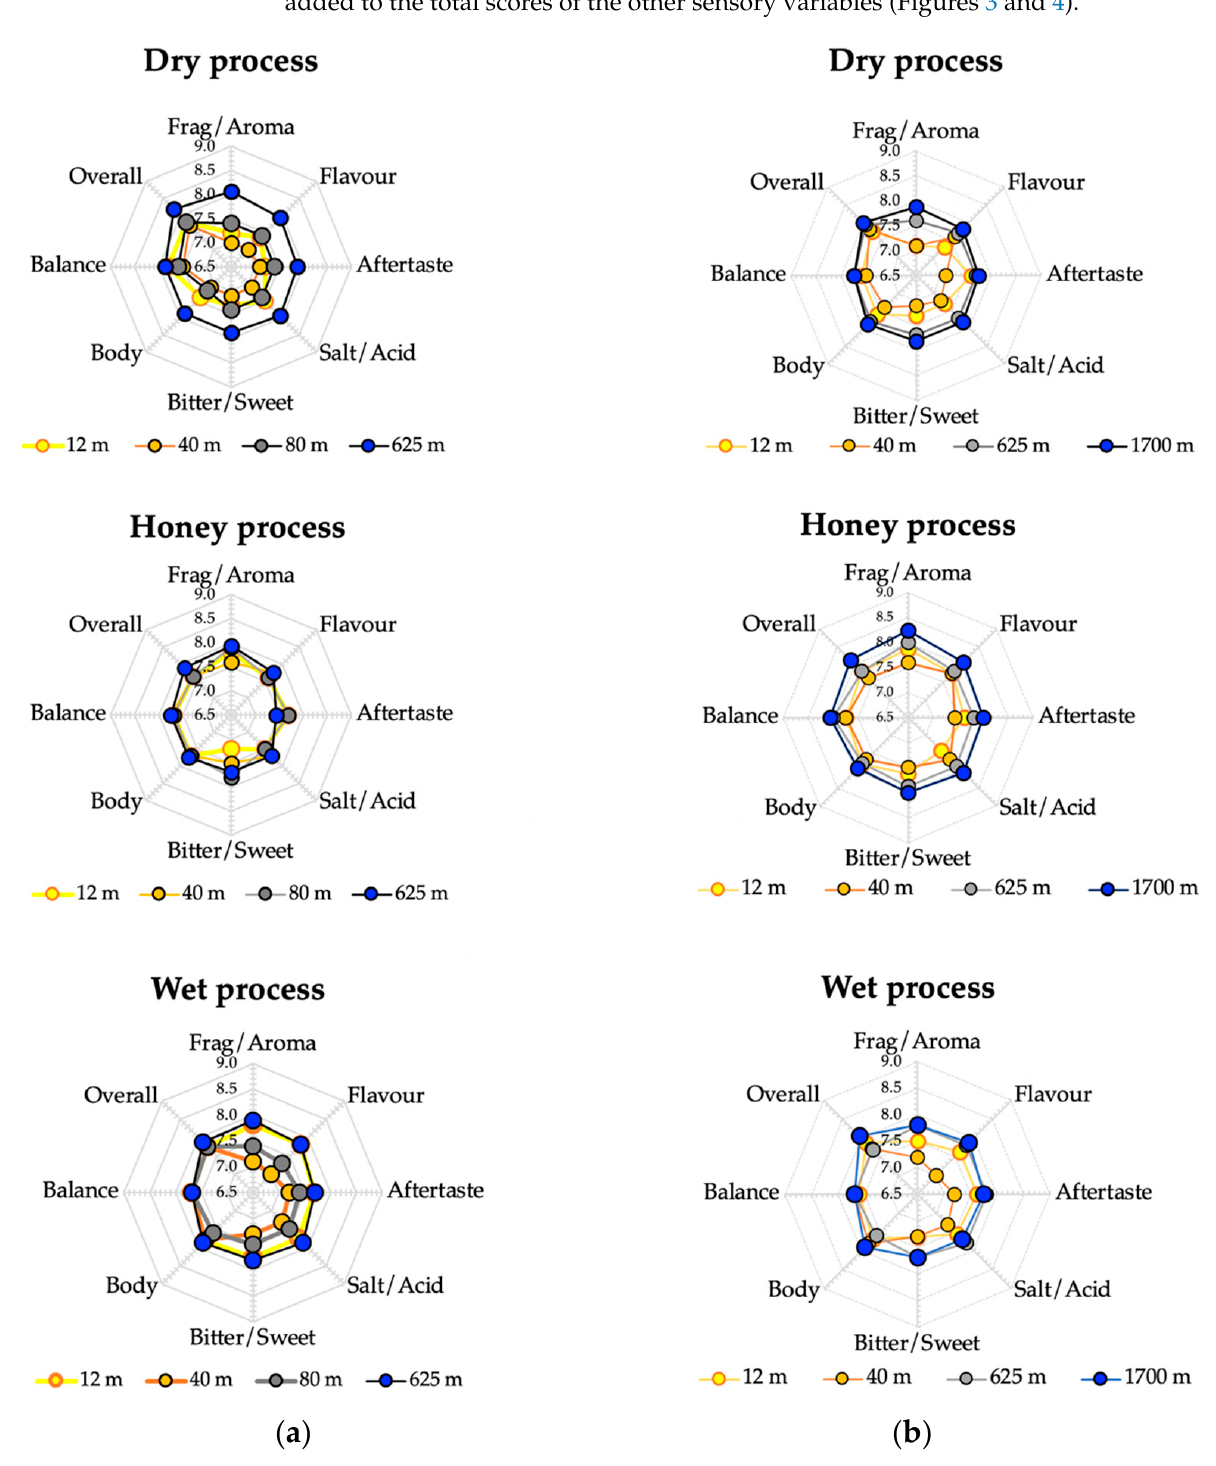
Figure 2. Average score of sensory profile evaluated by protocol cupping SCA (5 Q-Graders). Different altitudes: ( a ) congolensis; ( b ) conilon.